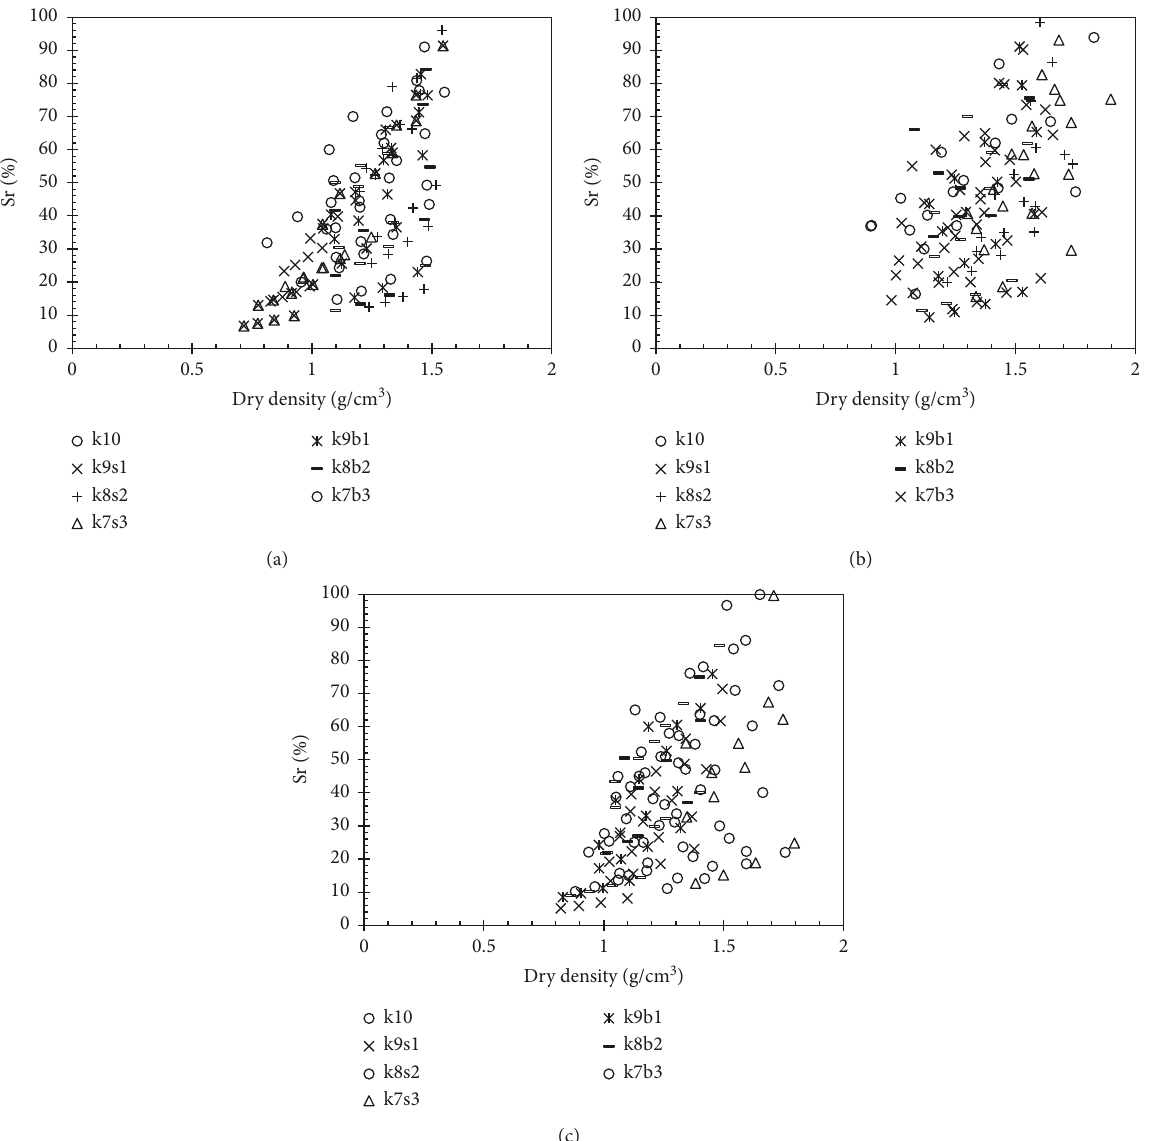
Figure 5: Degree of saturation (Sr %) against dry density (g/cm 3 ) of kaolin (K), kaolin-sand (K-S), and kaolin-bentonite (K-B) prepared at different salt concentrations: (a) 0M, (b) 0.5M, and (c) 1